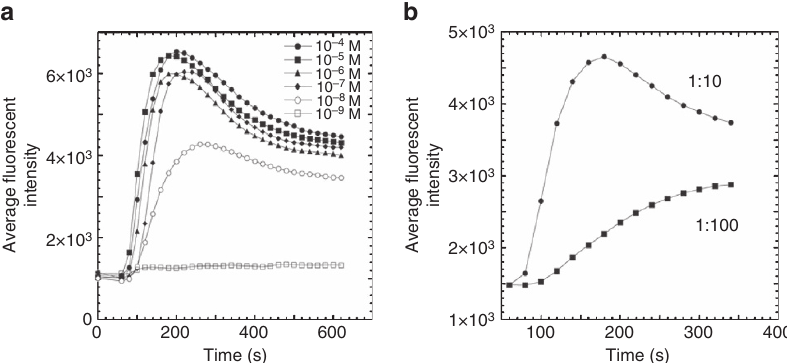
Figure 4 | Breadth of tested peptides and the sensitivity of CaFlux assay. ( a ) The dynamics and magnitude of calcium response by CD8 þ Tcells CER43 stimulated by strong agonist peptide GILGFVFTL (GL9) at various concentrations. ( b ) The dependence of the sensitivity of calcium response in CD8 Tcells CER43 induced by GL9 peptide ligand diluted in a mixture of non-stimulatory peptides (see ‘Methods’ section for details) at total concentration 10 (cid:2) 6 M and indicated ratios. The data are representative of 2 independent experiments and are based on the analysis of B 5,000